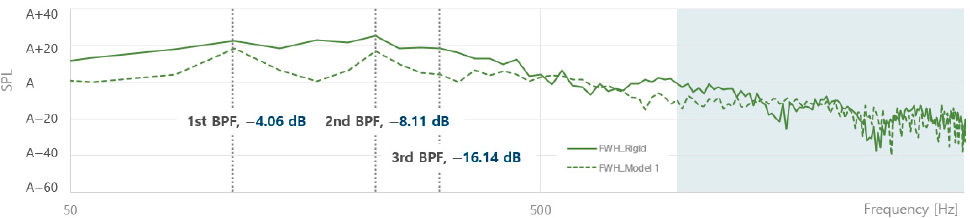
Figure 16. Sound pressure level of rigid and composite propellers (model 5) in the cavitating flow.